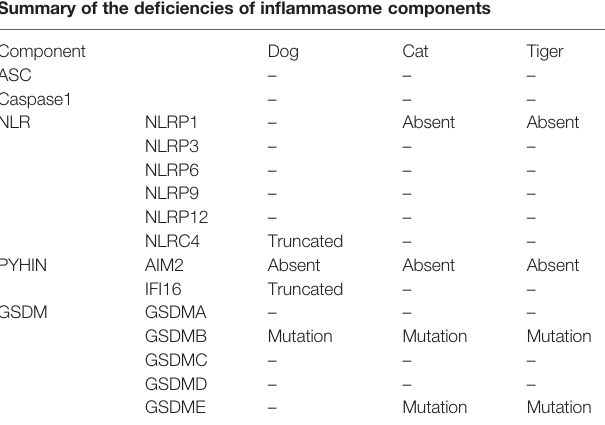
TABLE 3 | The de fi ciencies of key components of in fl ammasome pathway in dogs, cats, and tigers. Summary of the de fi ciencies of in fl ammasome components